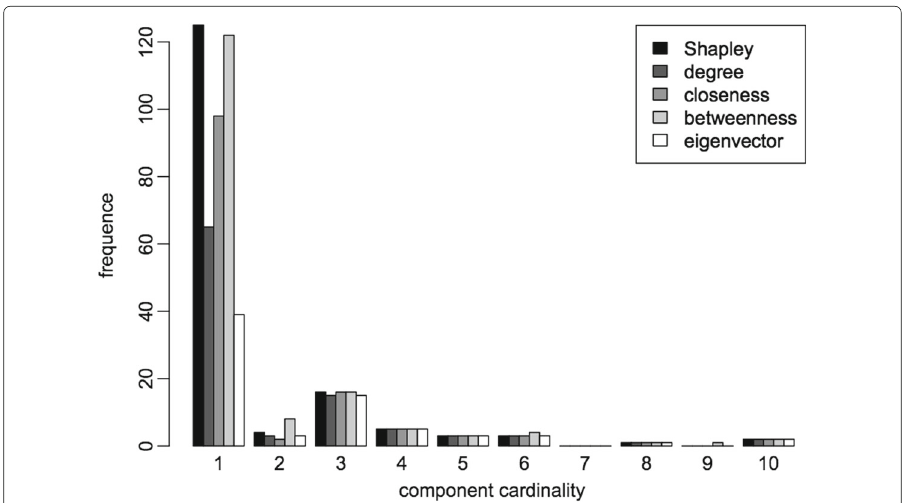
Fig. 5 Comparison of the frequencies of components cardinality. The histogram represents the frequency of components cardinality after the removal of the genes selected by the different centrality